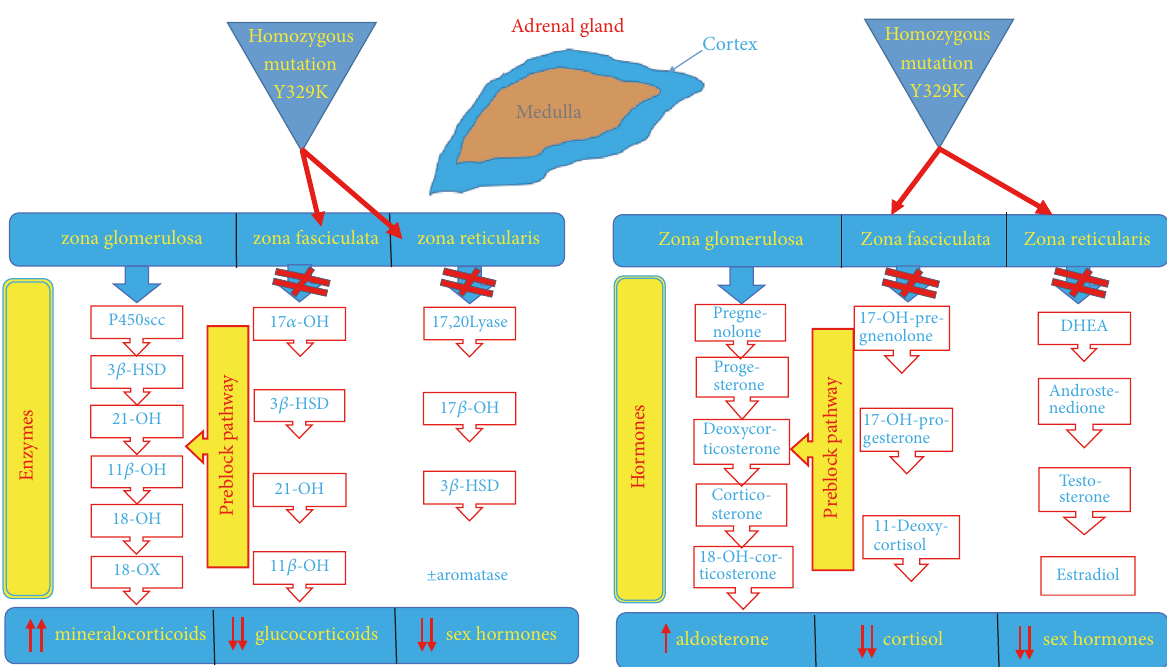
Figure 3: The adrenal steroid biosynthetic pathway: involved enzymes, hormones, and precursors. The “block” sites of hormone production in patients affected by 17 𝛼 -hydroxylase/17,20-lyase deficiency are highlighted by the red stop signs.